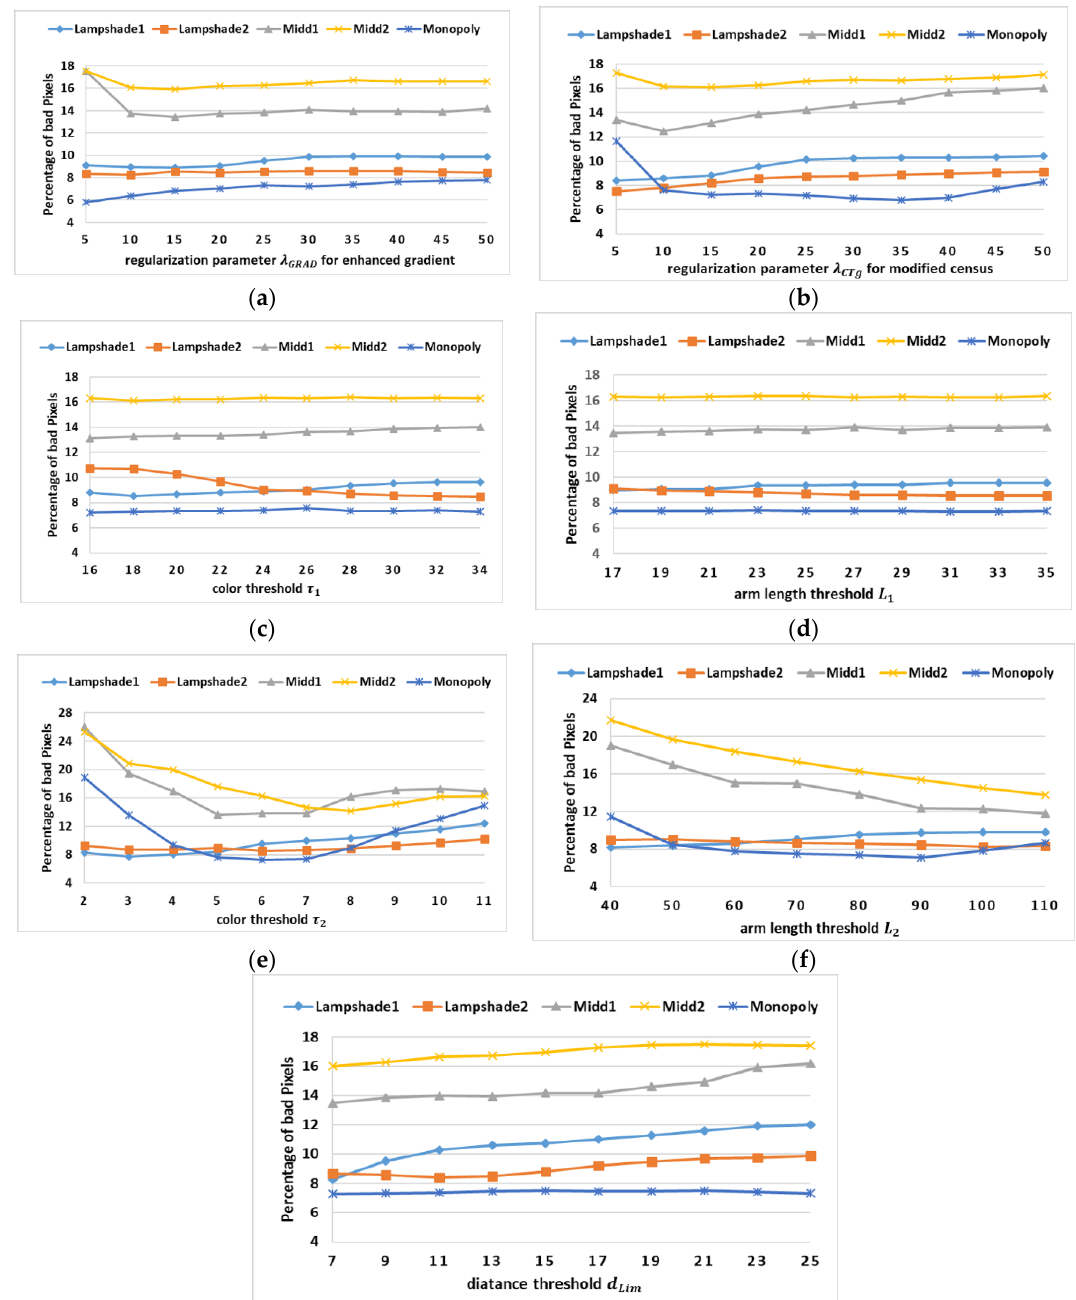
Figure 11. The experimental results on different parameter settings using the Middlebury textureless images. ( a ) Regularization parameter 𝜆 𝐺𝑅𝐴𝐷 for enhanced gradient-based matching cost; ( b ) regularization parameter 𝜆 𝐶𝑇𝑔 for modified census transform-based matching cost; ( c ) color similarity threshold 𝜏 1 ; ( d ) arm length threshold 𝐿 1 ; ( e ) color similarity threshold 𝜏 2 ; ( f ) arm length threshold 𝐿 2 ; ( g ) distance threshold 𝑑 𝐿𝑖𝑚 .